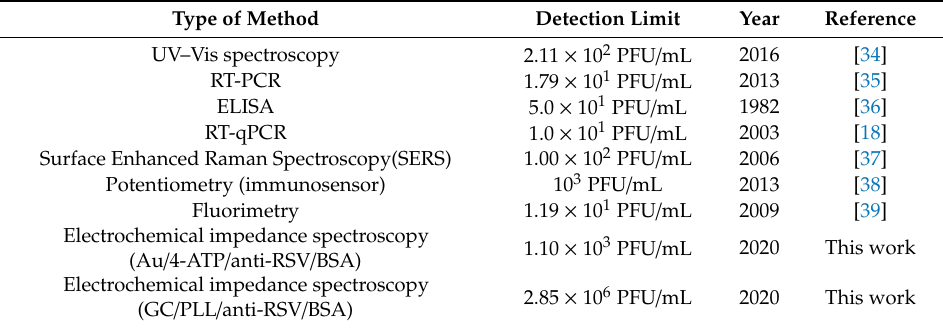
Table 3. A comparison of the analytical characteristics of the immunosensors developed in this work with relevant immunosensors for RSV detection based on the literature.